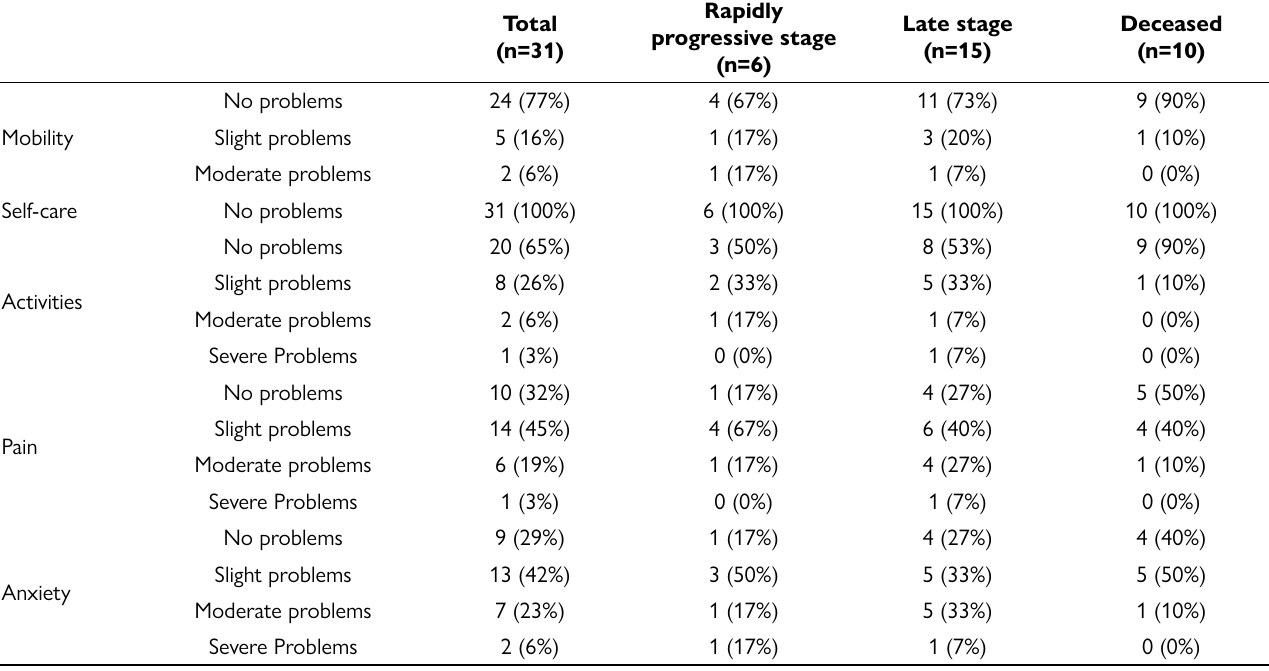
Late stage (n=15)